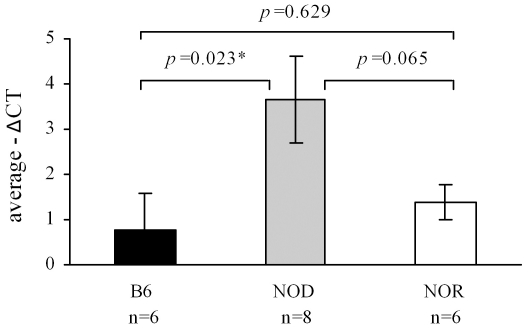
MammU6 is differentially expressed in the different mouse strains.Bar plots of the average MammU6 expression for each mouse strain are given with standard error bars. An ANOVA comparison detects a significant difference in the means, p-value of 0.049, an LSD p-value of 0.023 (B6 vs. NOD), and common SD of 2.4.